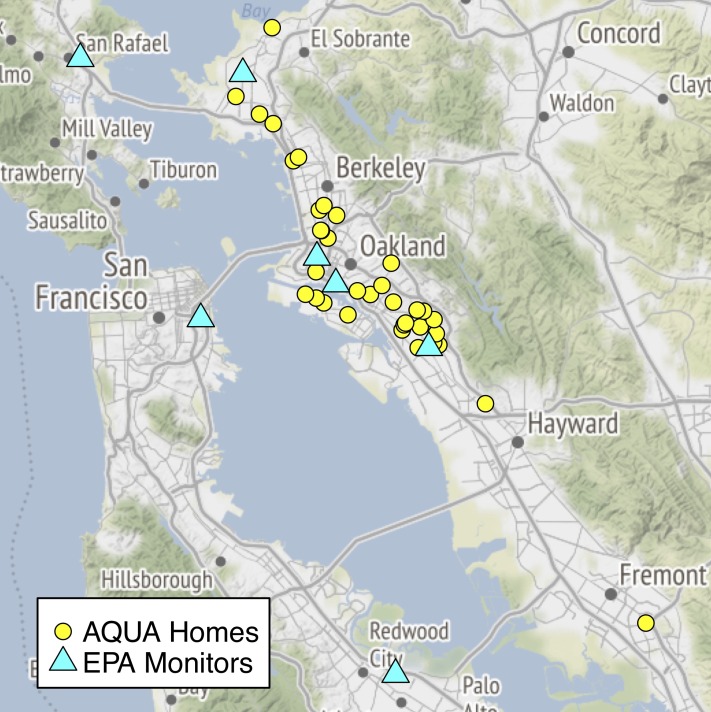
Map of the San Francisco Bay Area with locations of AQUA study households and local EPA monitoring stations noted.(Map tiles by Stamen Design, under CC BY 3.0. Data by OpenStreetMap under ODbL).